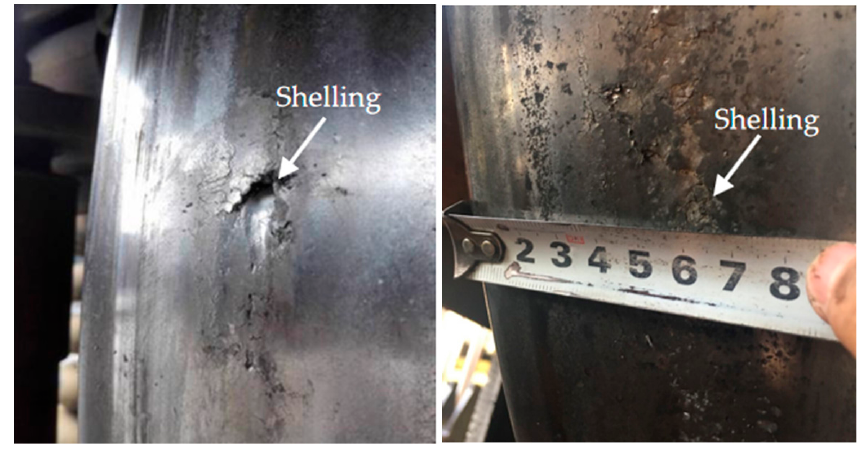
Figure 1. Shelling on locomotive wheel treads in China.